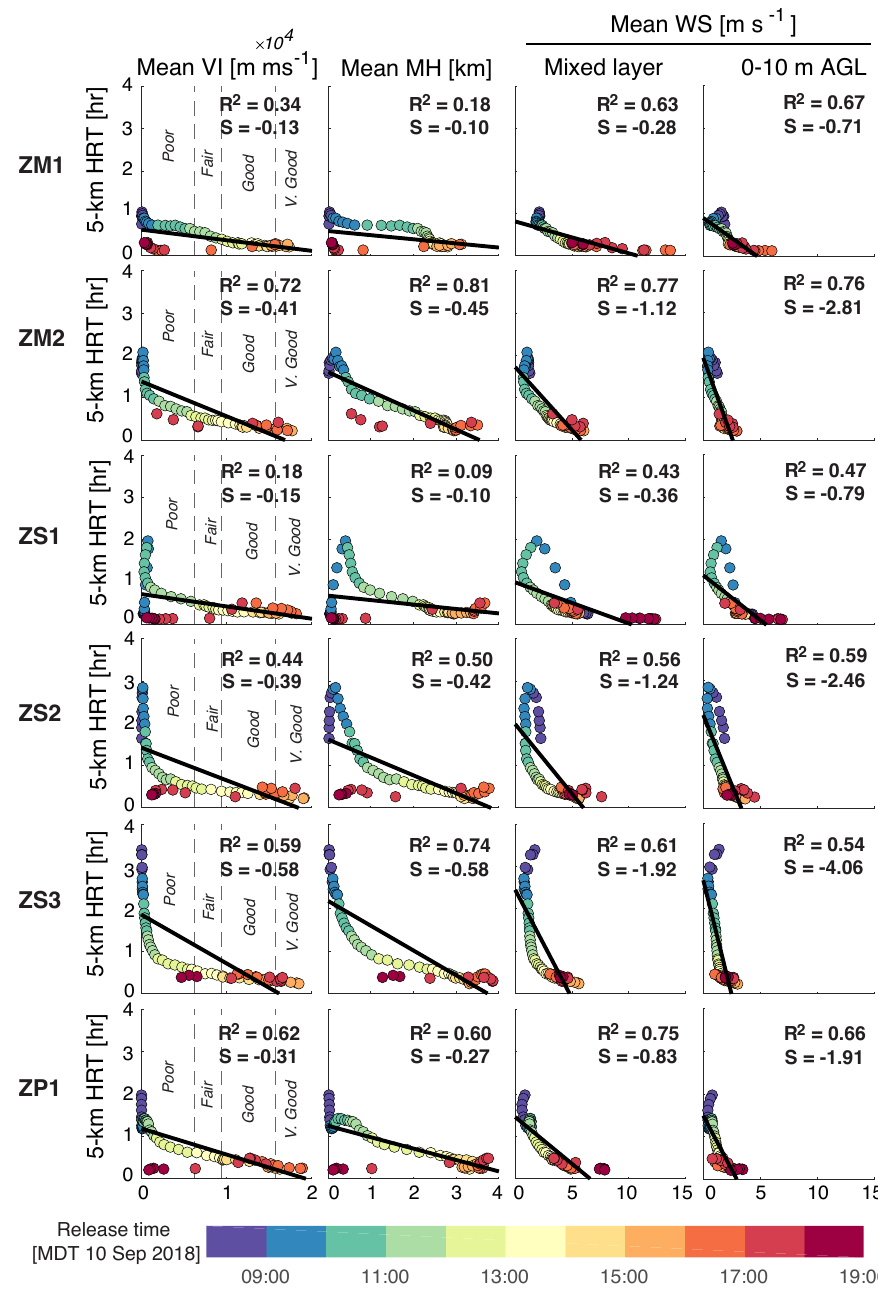
Figure 10. Scatter plots of ensemble mean HRT ( y -axis), and (from left to right) mean VI, MH, and WS (mixed layer and 0–10 m AGL) ( x -axis). Marker color corresponds to the one-hour release time block indicated in the color bar below the figure. The thick black line is the linear regression, S is the normalized slope, computed as the slope divided by the plot aspect ratio [(y max − y min )/(x max − x min )], and R 2 is the coefficient of determination. State of Colorado VI adjective ratings are provided in the first column, for reference only (adjective ratings developed by state of Colorado, with little documentation of their